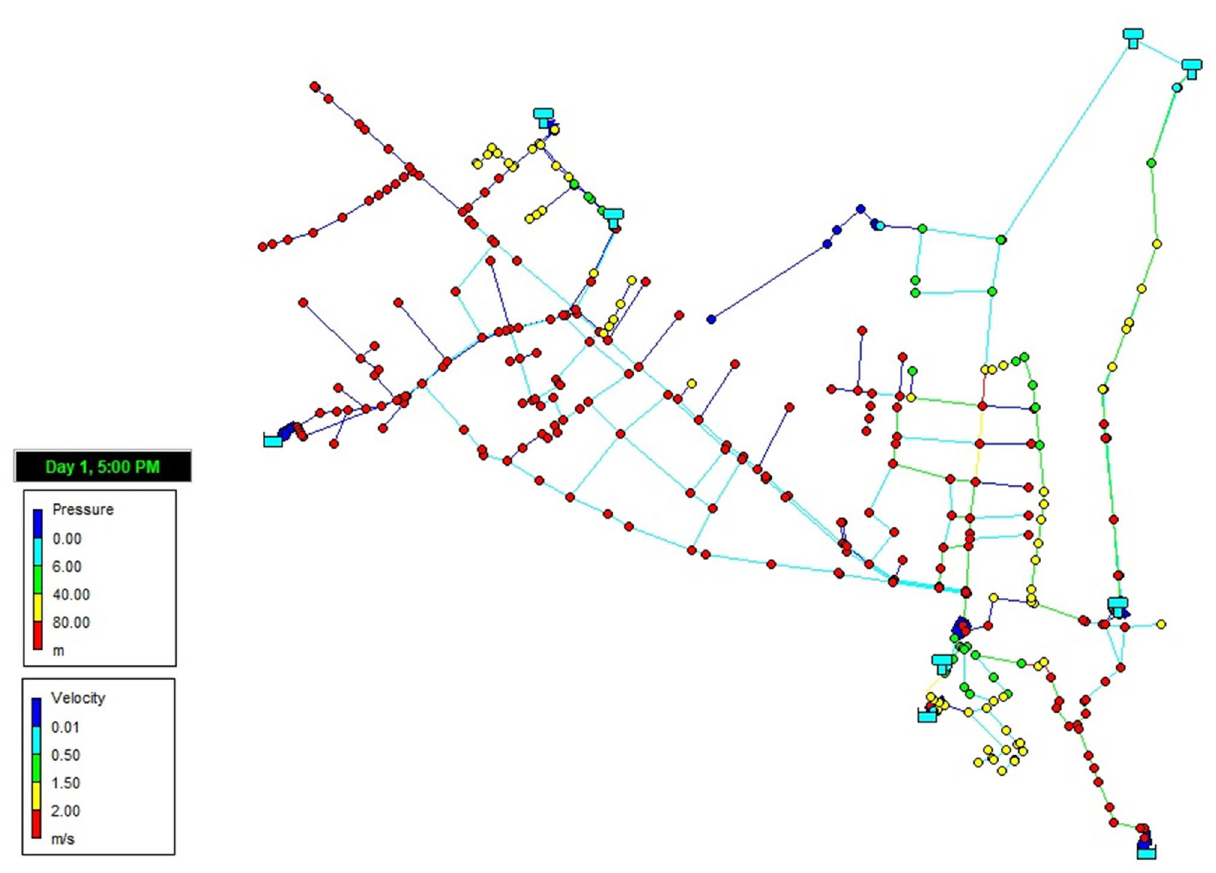
Fig. 3 EPANET simulation of the Goma's water supply network